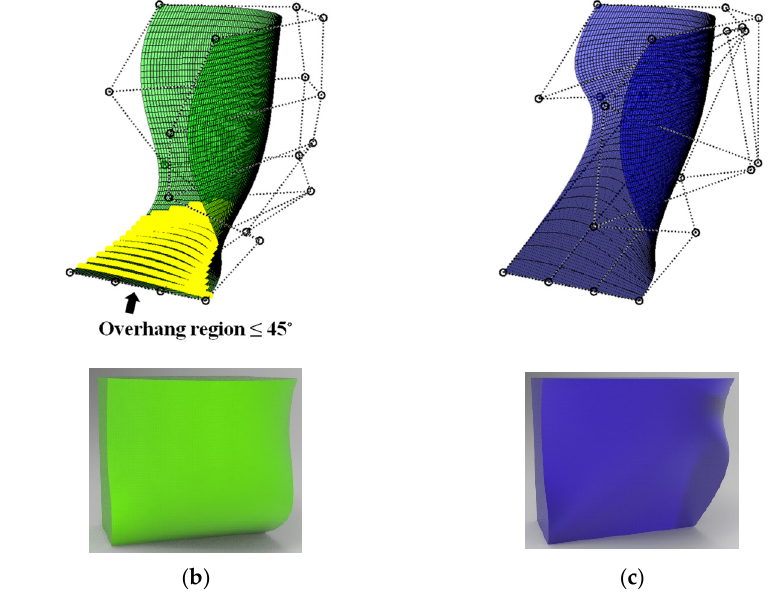
Figure 13. Comparison of surface-based models: ( a ) Original model; ( b ) Modified model with 20° threshold angle; ( c ) Modified model with 45° threshold angle.